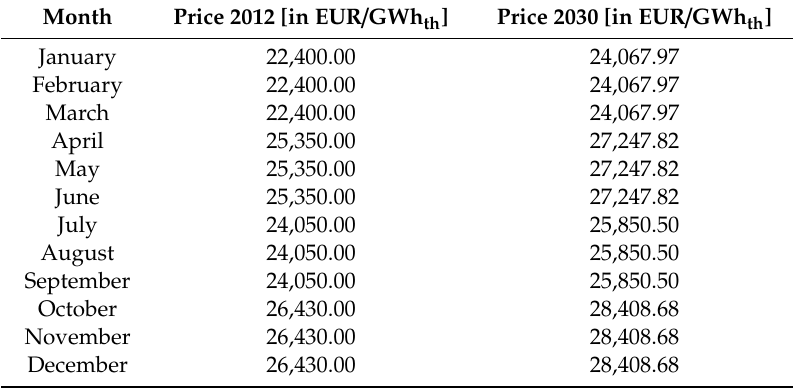
Table A1. Cross-border natural gas prices based on NCG natural gas quarter futures for 2012 and own assumptions for